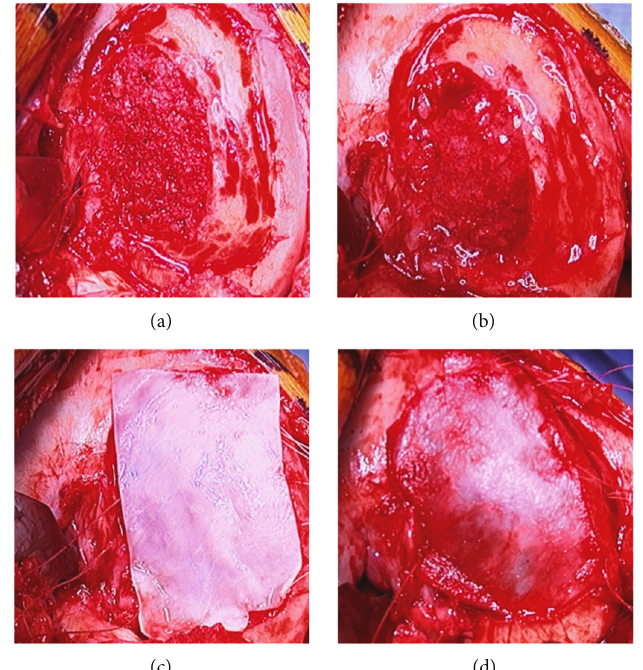
Figure 9: Bone grafting and fi rst MACI stabilization. (a) Bone graft defect. (b) Fibrin glue base lesion. (c) MACI graft # 1 cell layer up. (d) MACI graft # 1 suture stabilization.